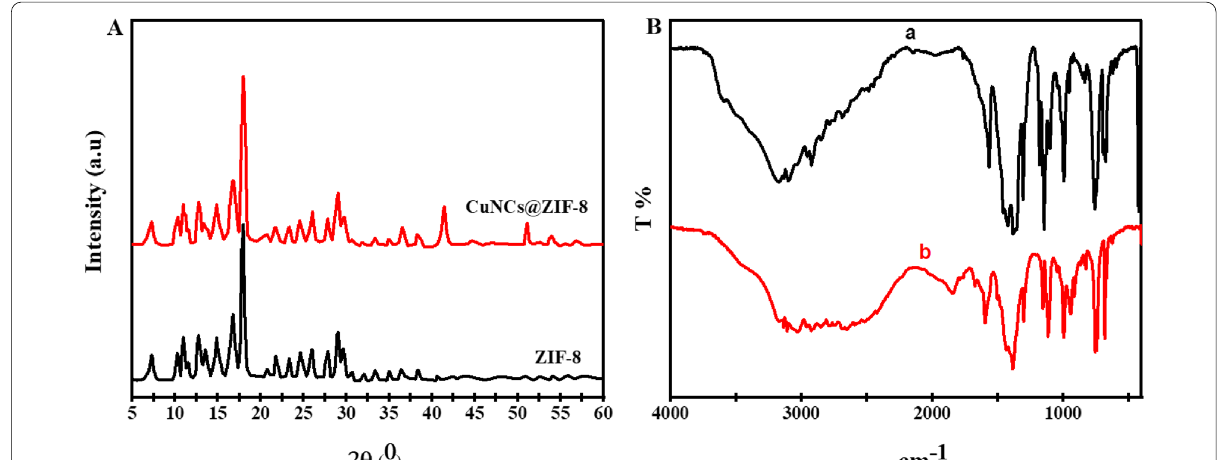
Fig. 4 A XRD patterns of the prepared ZIF-8 and CuNCs@ZIF-8; B (a) FTIR spectrum of ZIF-8 (black line) and (b) CuNCs@ZIF-8 (red